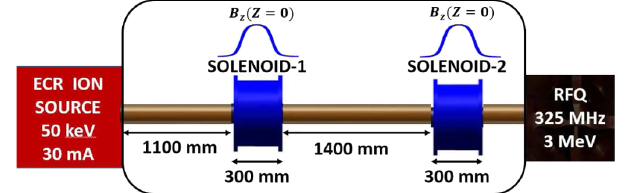
FIG. 1. Schematic of the beamline transporting a 50 keV, 30 mA proton beam from the ion source to the 3 MeV RFQ.